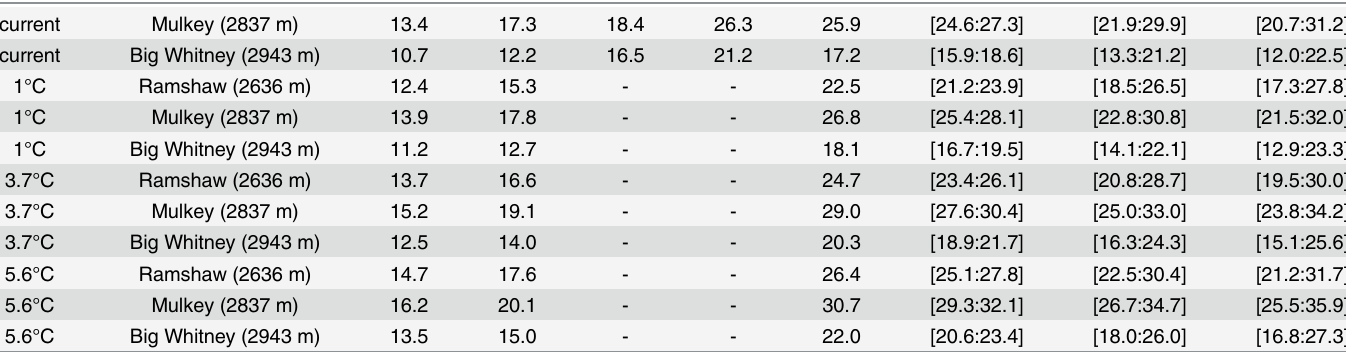
Table 4. Observed and expected (modeled) temperatures.